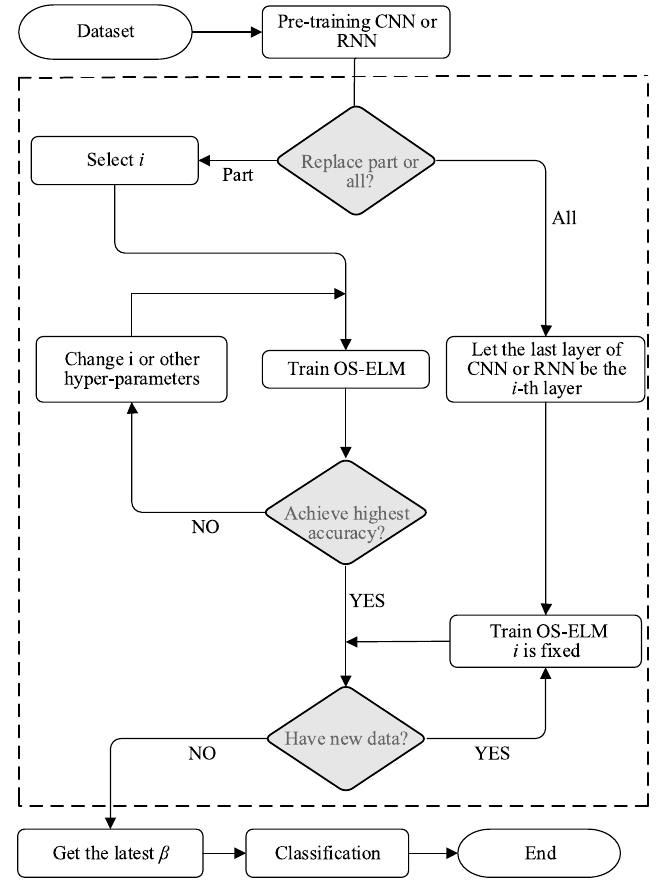
Figure 2. The training process.